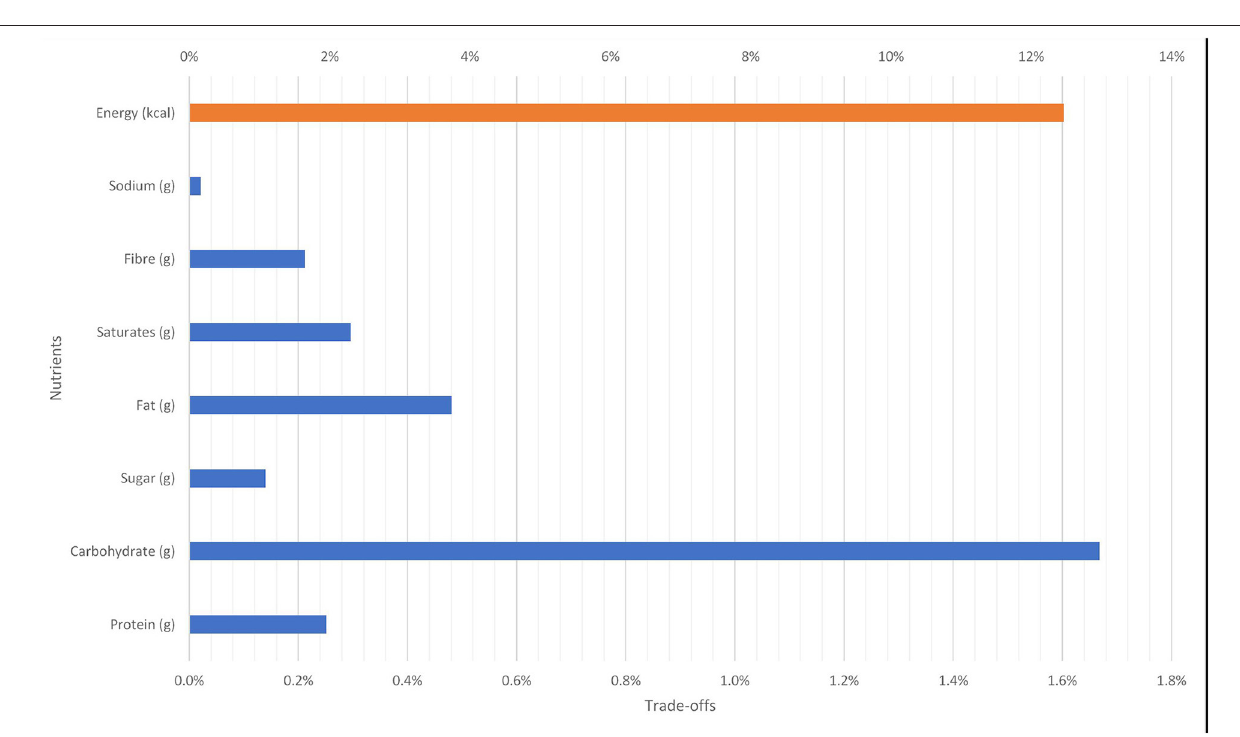
Frontiers in Nutrition |